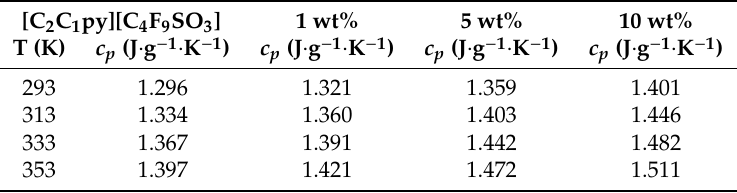
Table 2. Experimental values of isobaric specific heat capacity of xGnP / [C 2 C 1 py][C 4 F 9 SO 3 ] at the analyzed